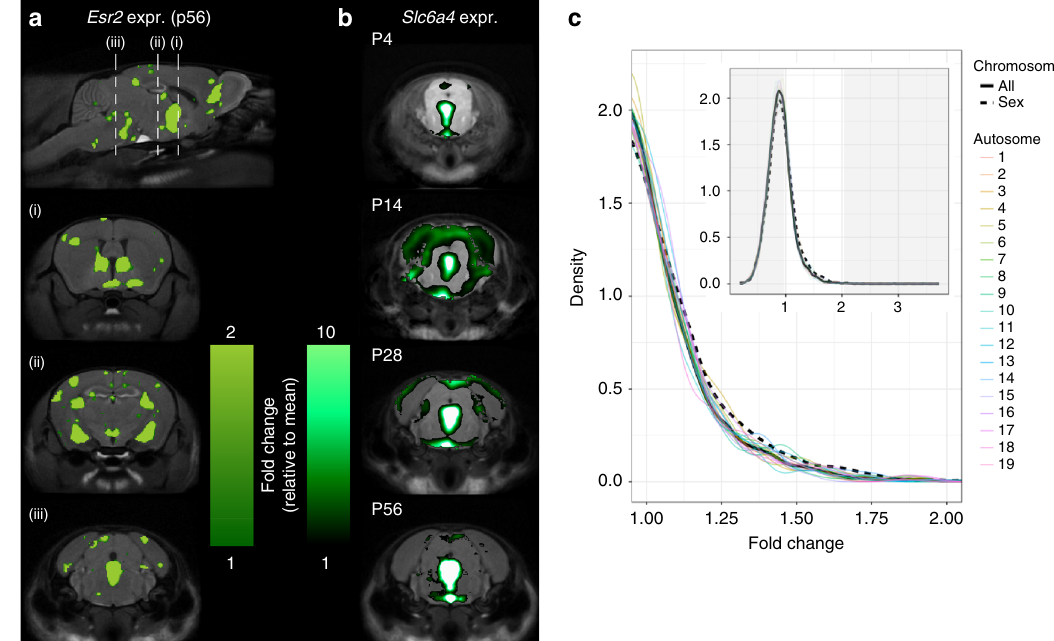
Fig. 7 Gene expression patterns overlaid onto MRI results. a Spatial Gene Expression of Estrogen Receptor 2 ( Esr2 ) in the adult mouse brain (ABI Dataset ID: 71670737) overlaid onto the MRI average in our study. Esr2 and Esr1 genes (Supplementary Fig. 5) were found to be preferentially expressed in regions with sexually dimorphic development. To measure preferential expression, we used a fold-change measure dividing the mean expression signal in regions with sexually dimorphic development by the mean expression in the brain. Esr2 had fold-change of 2.9 and Esr1 had a fold-change of 2.1. This was primarily driven by expression in Cluster 1, where the genes had fold-changes of 9.9 and 6.1, respectively. b Slc6a4 expression throughout development. Slc6a4 had the highest preferential expression (fold-change of 3.7) in sexually dimorphic regions primarily driven by expression in Cluster 3 (7.0 fold-change). Time course of Slc6a4 gene expression reveals peak expression in mid-brain and hind-brain between p4 and p28. c Genes on sex chromosomes have a higher likelihood of preferential spatial expression in regions with sexually dimorphic development. We computed the fold-change for all the genes in the Allen Brain Atlas and created the density plot marked by the solid line. The dashed line indicates the density plot associated with only the genes on the sex chromosomes and the colored lines represent genes on different chromosomes. In both the overall density plot (inset), and on the zoomed density plot, we see that genes on sex chromosomes have signi fi cant preferential expression bias (One-sample Kolmogorov – Smirnov test: D (cid:2) ¼ 0 : 052 ; P ¼ 0 : 02 ; n ¼